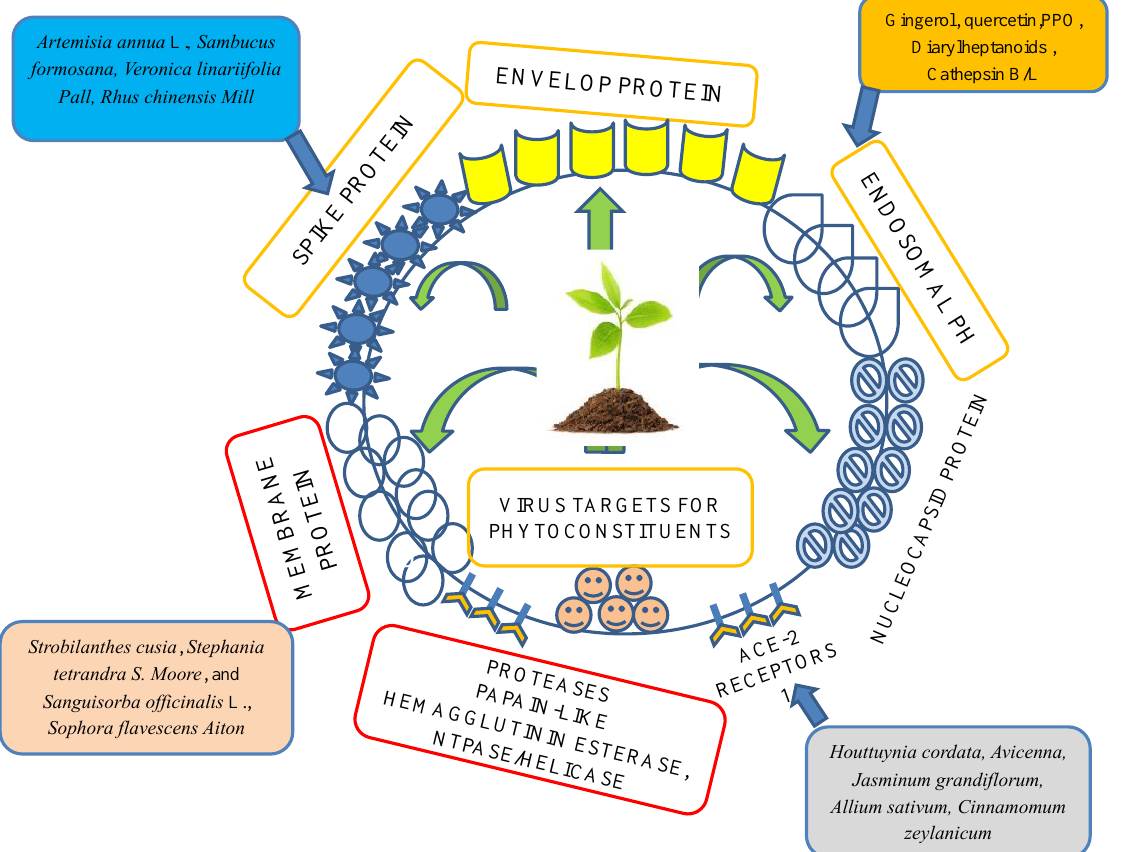
Figure 2. Plant- and herb-targeted envelope protein, spike protein, membrane protein, protease inhibitors, ACE-2 receptors, nuclear capsid protein, and endosomal-like parts of a virus.